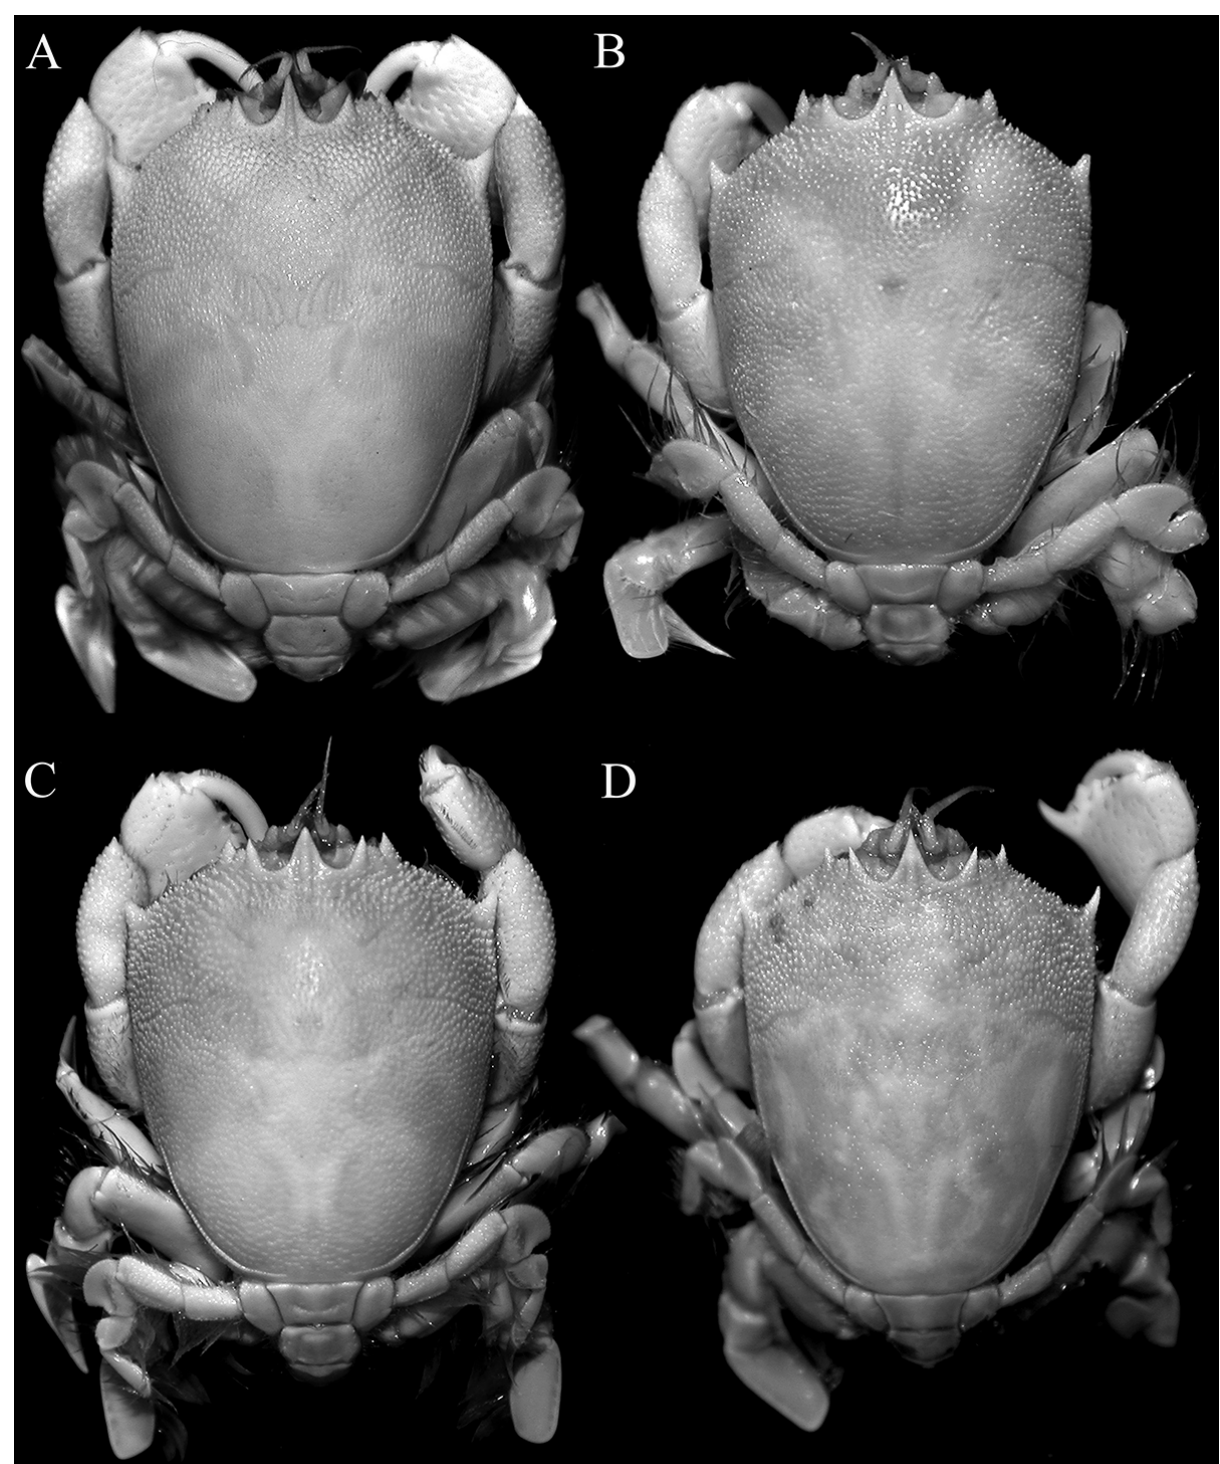
Figure 1. Overall dorsal habitus. A, Umalia trirufomaculata , holotype male (20.4 x 26.3 mm) (WAM 348-60), Western Australia; B, U. trirufomaculata , male (11.8 x 15.6 mm) (ZSI), Andamans; C, U. misakiensis , male (23.4 x 28.9 mm) (ZRC 2018.1378), Philippines; D, U. misakiensis , male (16.0 x 21.8 mm) (ZRC 2001.0637),